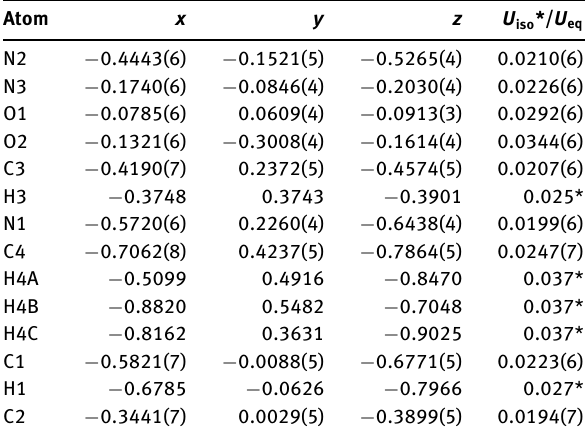
Table 2: Fractional atomic coordinates and isotropic or